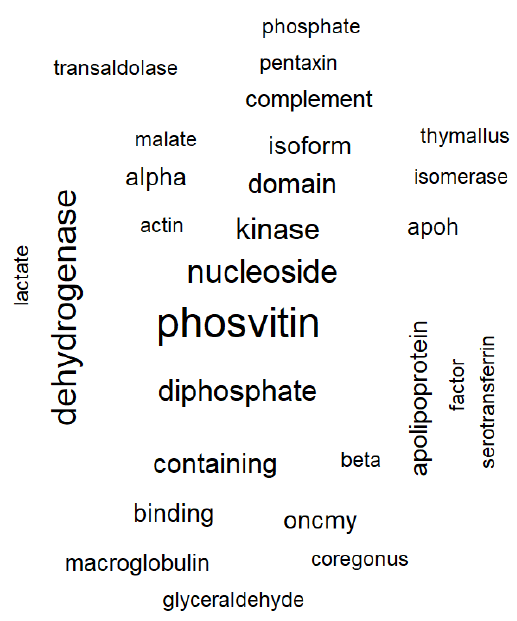
Figure 6. Words cloud by frequency of occurrence among identified proteins. Note: the closer to the center and the larger the font, the more often the word appears. The minimum frequency of occurrence of a word is 3 times. Biomolecules 2022 , 12 , 133